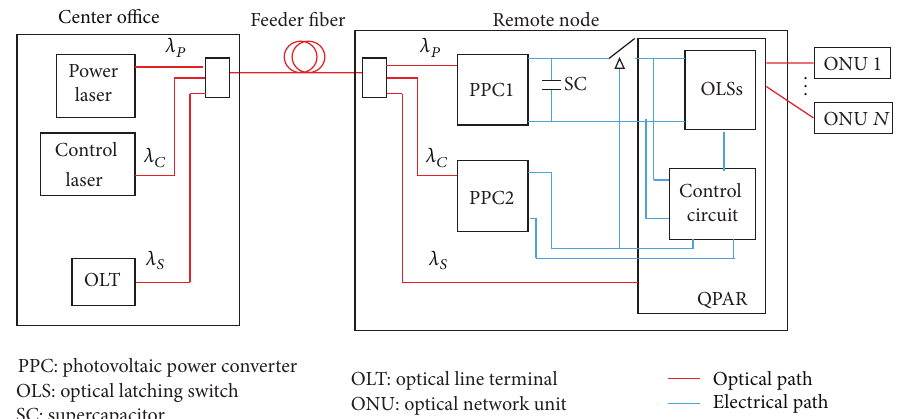
Figure 1: General architecture of the QPAR remote power system.